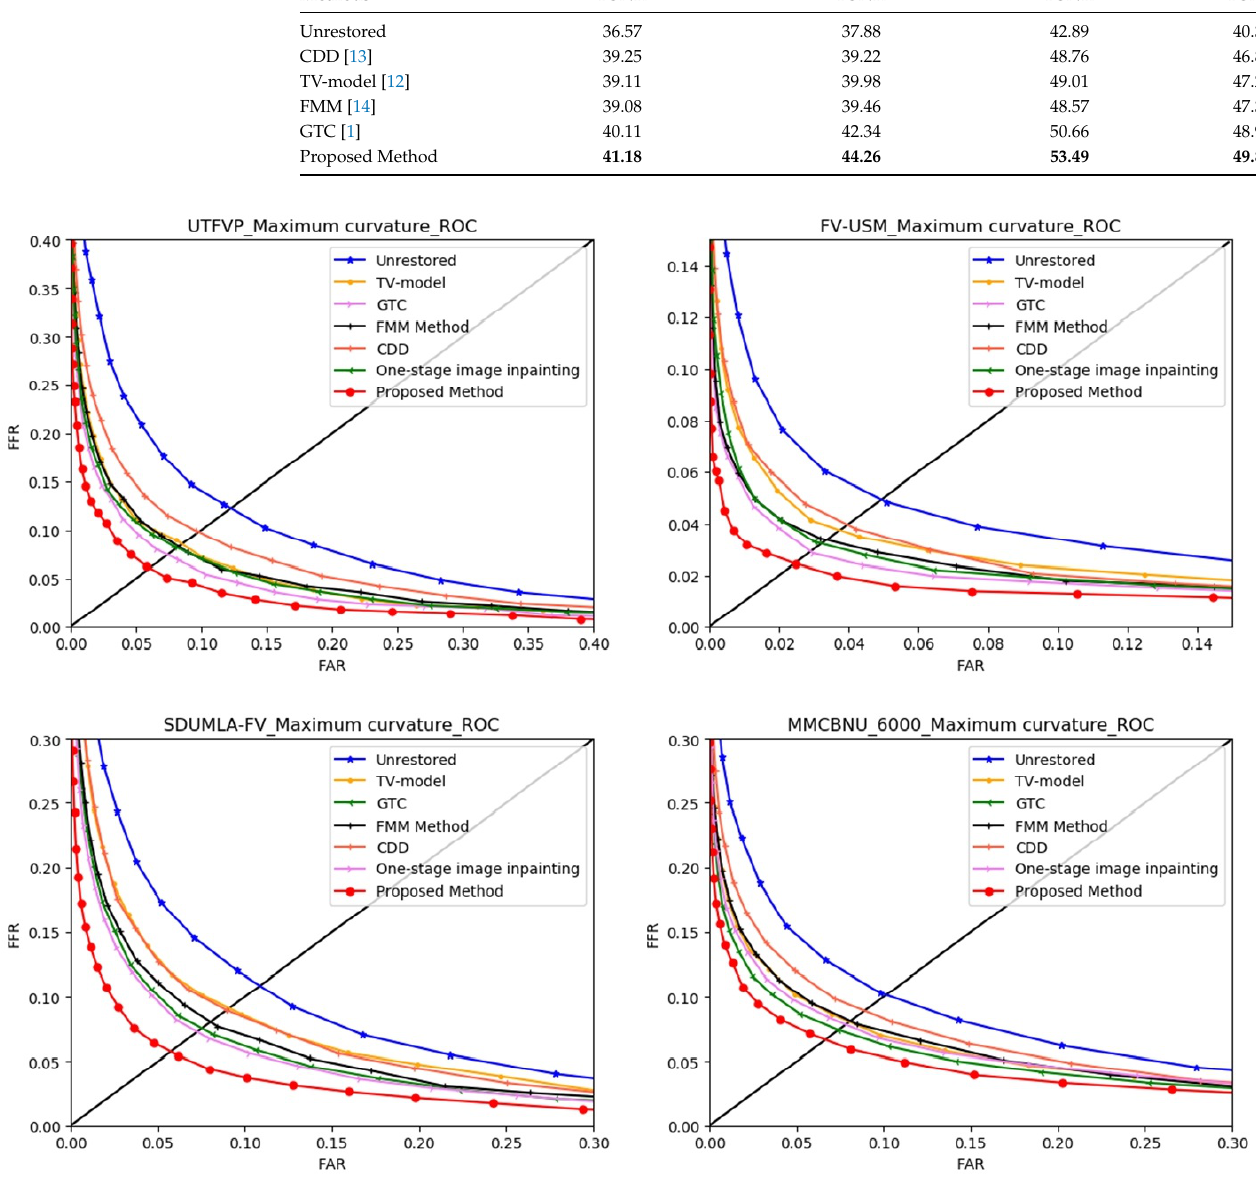
Figure 10. The ROC curves of various image inpainting methods on the different public